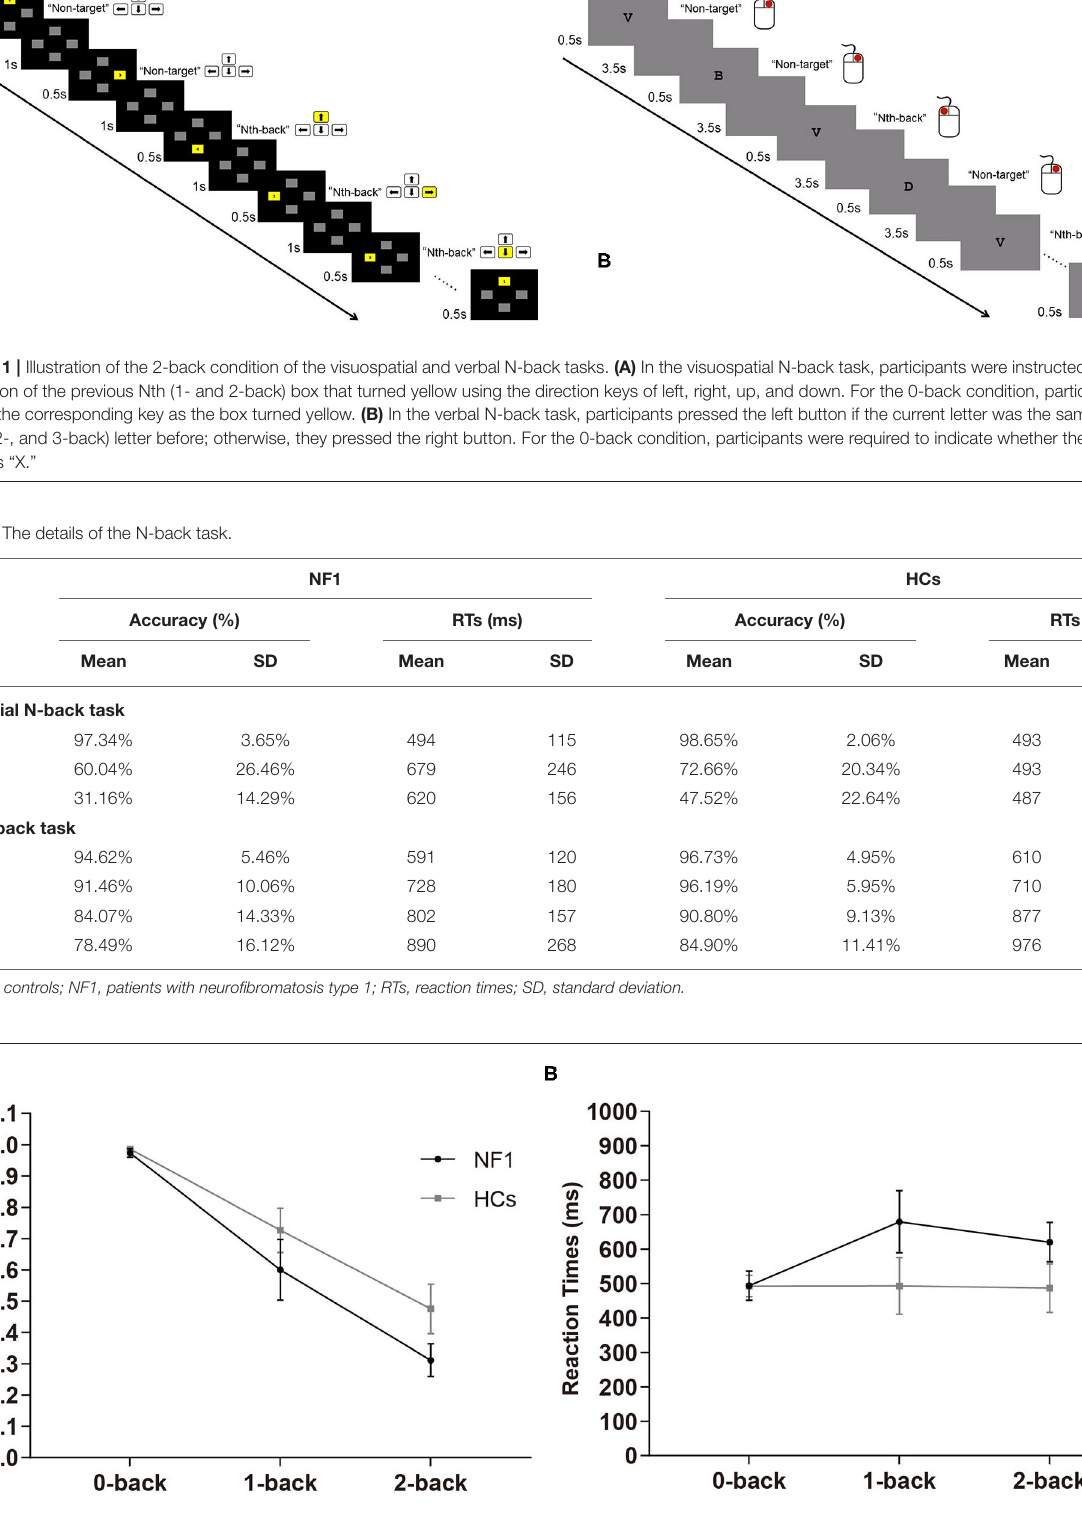
FIGURE 2 | Results of accuracy (A) and reaction times (B) in the visuospatial N-back task. Adult patients with NF1 performed poorer visuospatial WM than HCs. Error bar was 95% confidence interval. HCs, healthy controls; NF1, neurofibromatosis type 1.